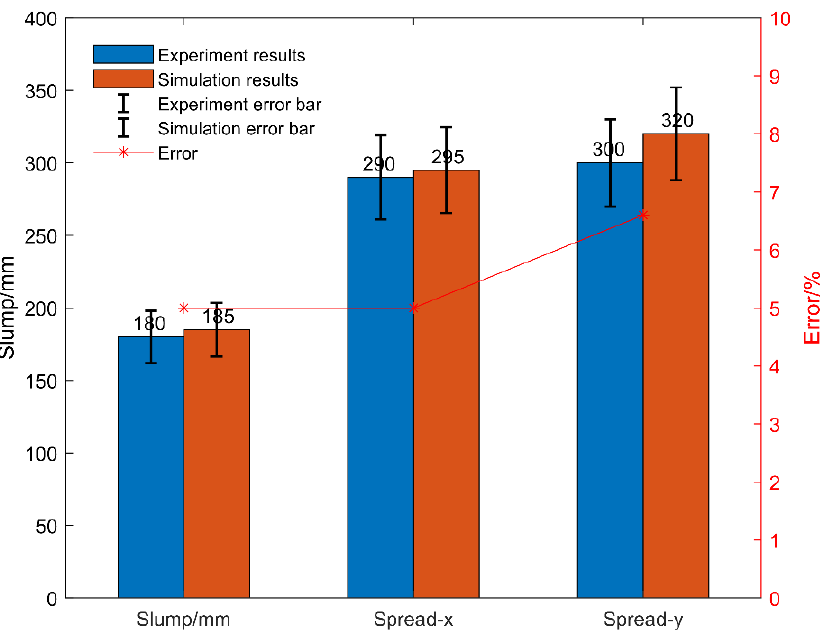
Figure 14. Error analysis of Group 2.